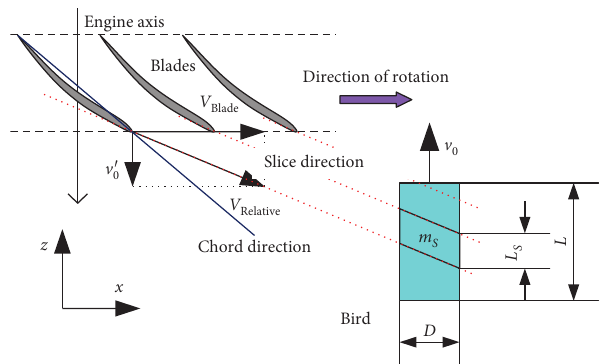
Figure 2: The bird slicing action by the blade leading edge.